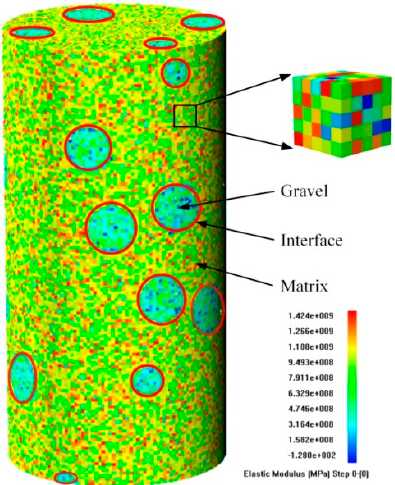
Figure 16. The numerical model of glutenite specimen: 3D mesh distribution diagram of the elastic modulus.